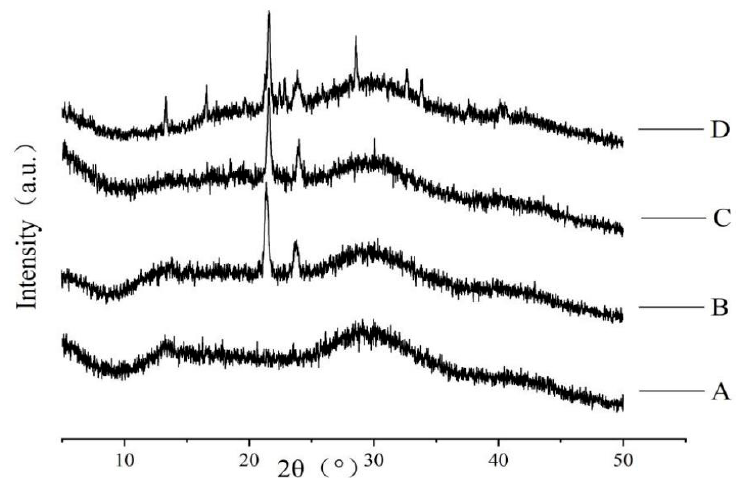
Figure 4. Effect of each component on crystal structure of composite film (A: pure SA membrane; B: SA/CW composite membrane; C: SA/CW/G composite membrane; D: SA/CW/G/Vc-Ca composite membrane).